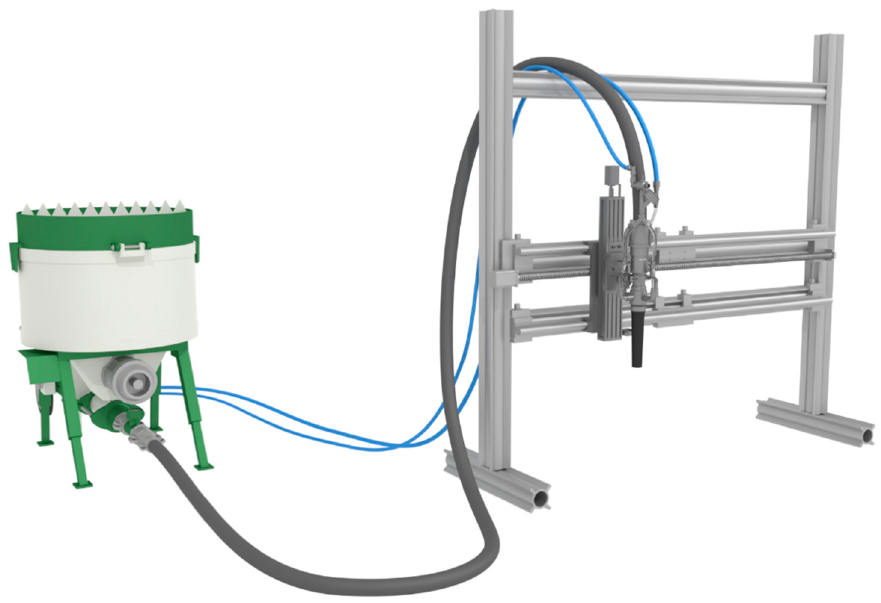
Figure 4. Experimental setup for the Smart Additive Manufacturing Material Investigator (SAMMI) for Shotcrete 3D-printing (SC3DP) experiments. x – z -linear axis with a nozzle.